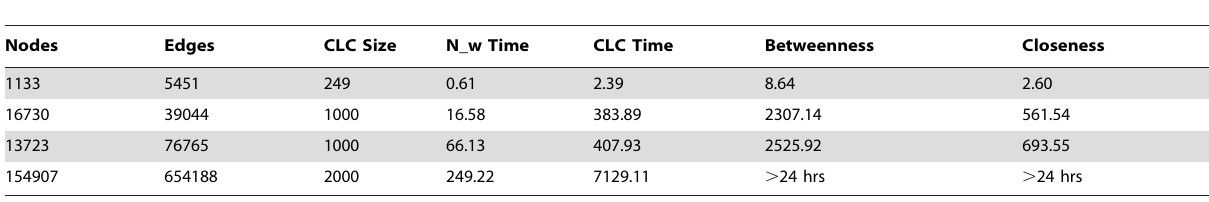
Table 6. Runtime of GREEDY- C LC 2, Closeness, and Betweenness.